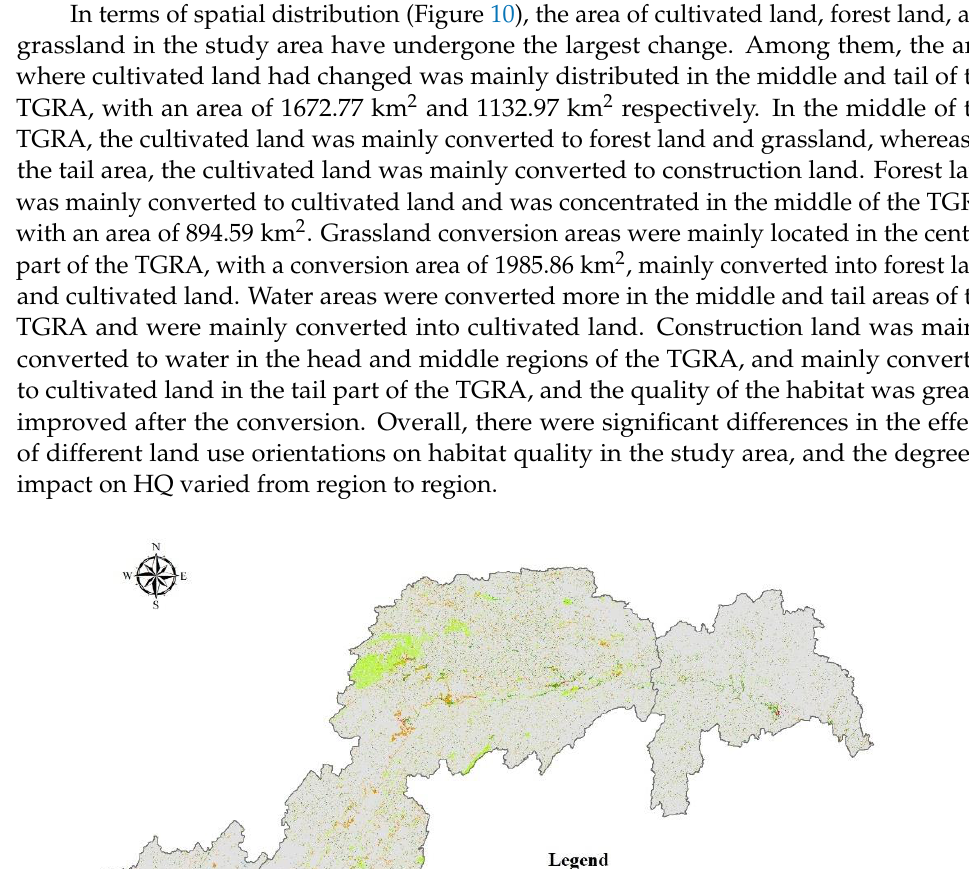
Figure 10. Land use change area from 2000 to 2020.